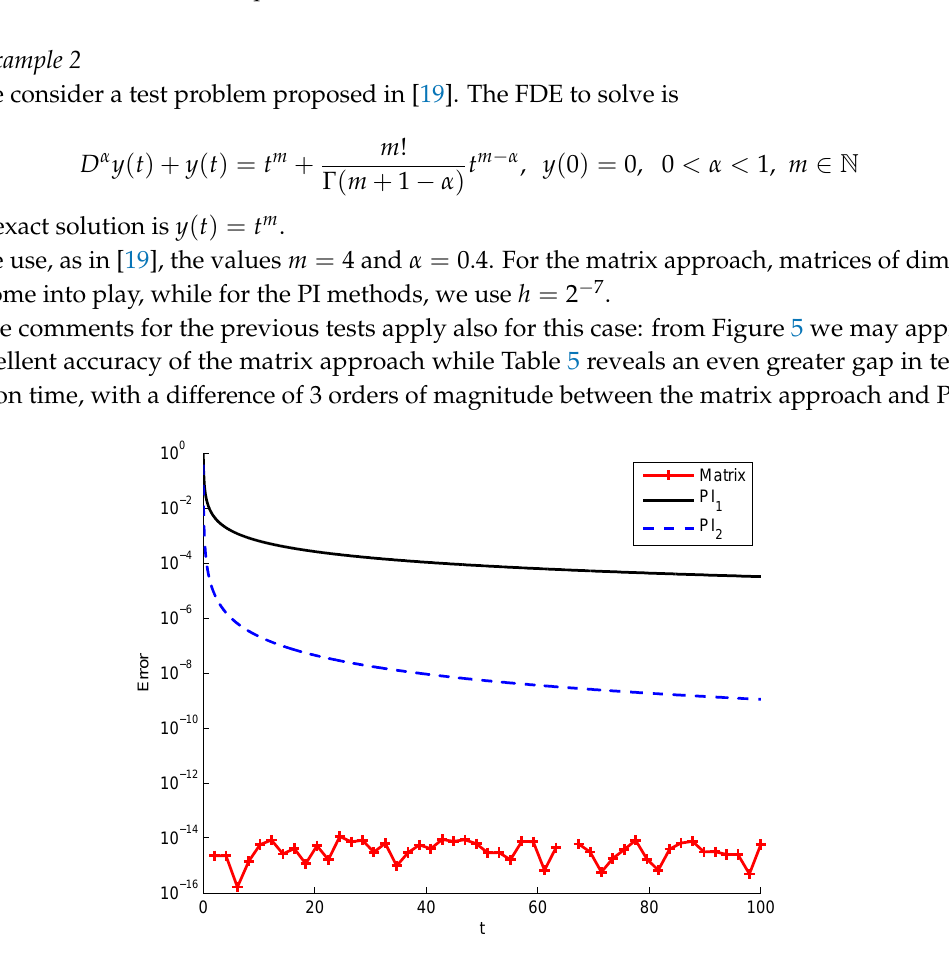
Figure 4. Relative error for the matrix approach and the product integration (PI) methods compared with the exact solution for Equation (13).